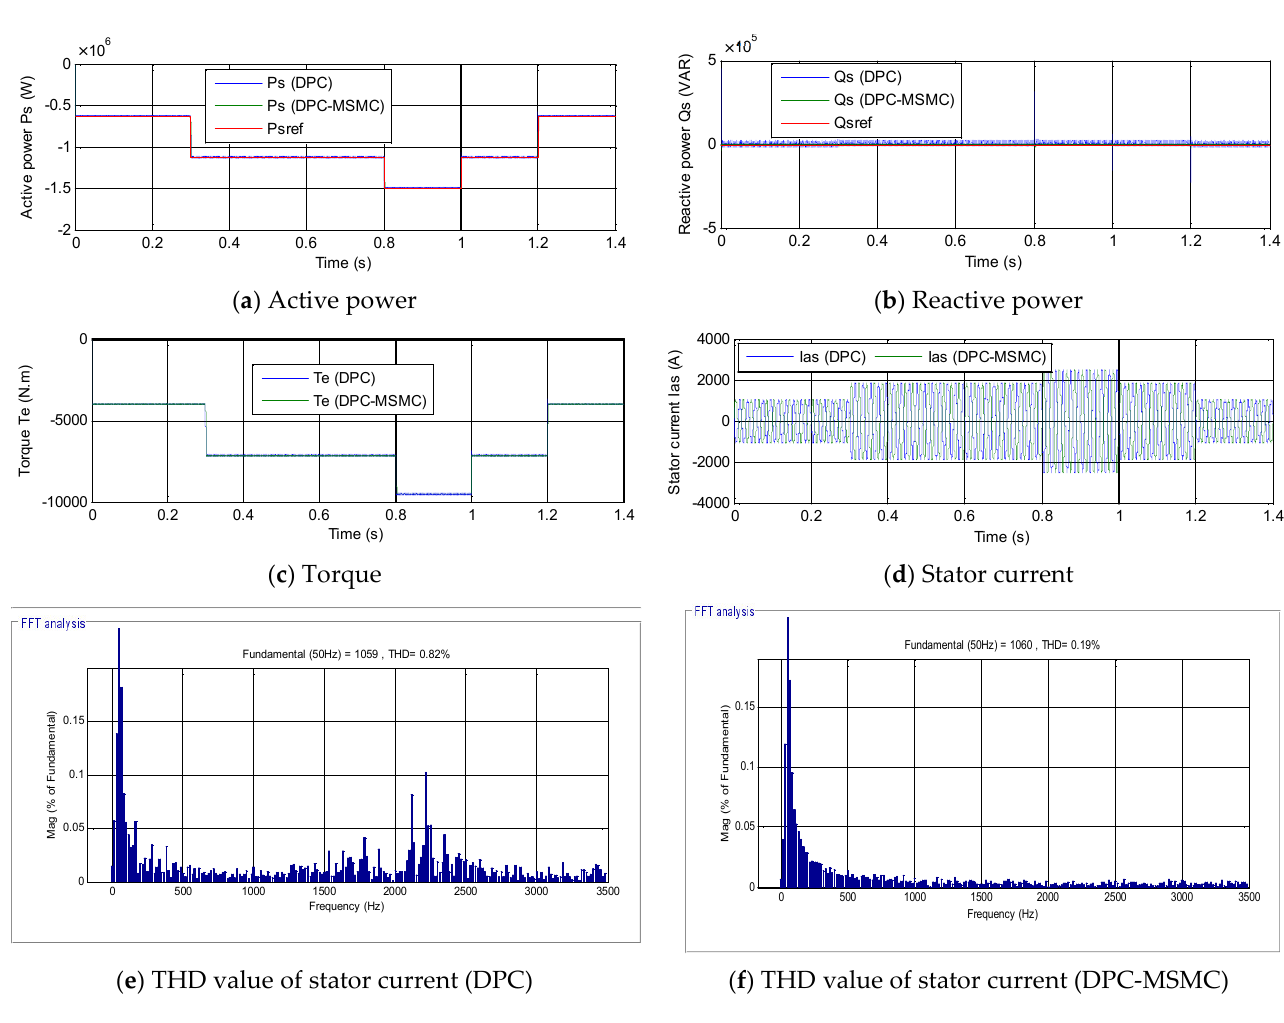
Figure 7. Simulated results from the steps speed wind test.